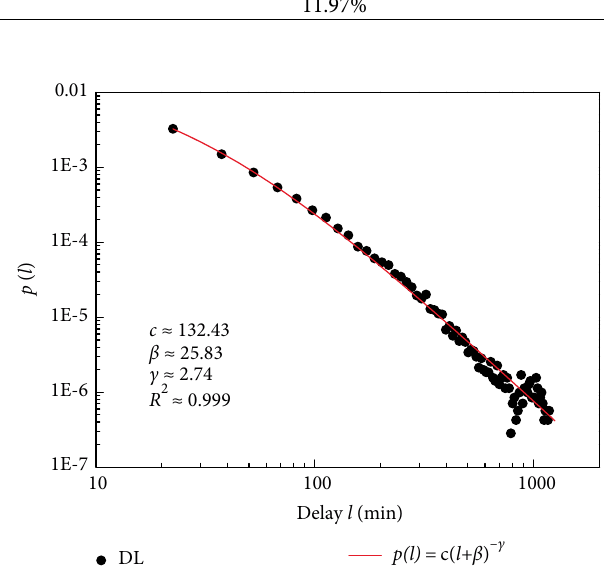
Figure 1: Log–log plots of PDF of the flight departure